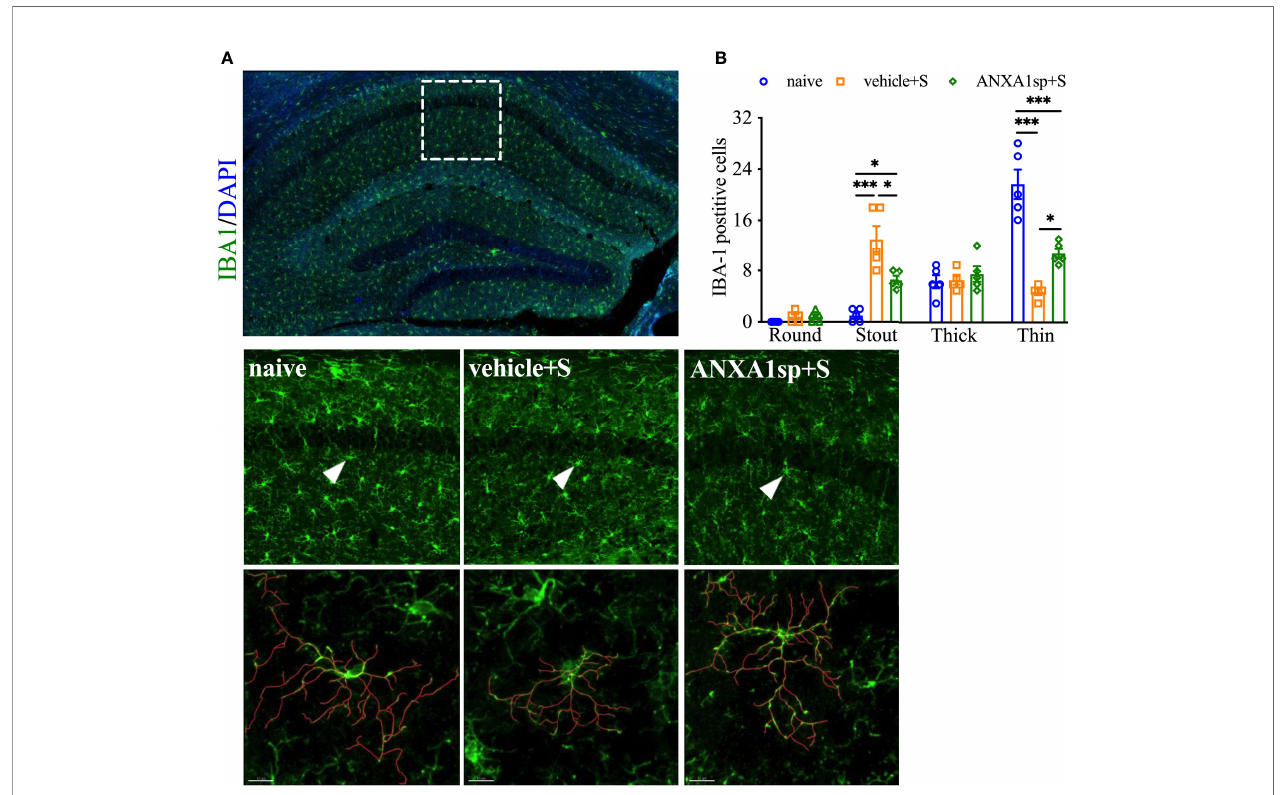
FIGURE 2 | Effects of ANXA1sp on microglial morphology after surgery. Microglial morphologic changes were signi fi cantly curtailed 24 h after orthopedic surgery in adult mice pretreated with ANXA1sp (A, B) . Microglial morphology was quanti fi ed based on four morphologic subtypes: Round, Stout, Thick, and Thin; three representative areas/mice were used for quanti fi cation and one single microglia was represented in the reconstruction (red indicates fi lament tracing). Data are presented as mean ± SEM from hippocampal CA1 area. n = 5/group. * P < 0.05, *** P < 0.001. Analyzed by one-way ANOVA with Tukey ’ s multiple comparisons test. Scale bar: 20 m m. Representative data are from two independent